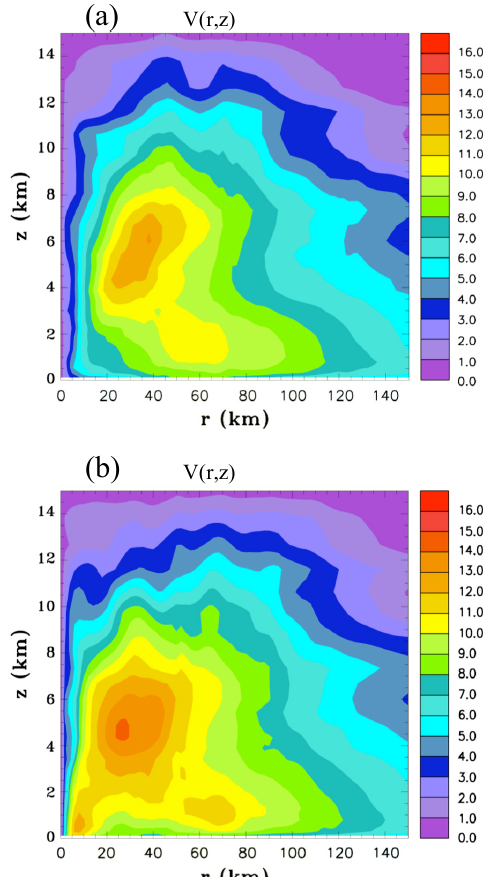
Fig. 5. Azimuthally averaged tangential velocity V (r,z) for Exper- iment 2, at (a) t = 79h, and (b) t = 83h. The contour interval is 1ms − 1 . Figure 5. Azimuthally averaged tangential velocity V(r,z) for Experiment 2, at (a) t=79 h, and (b) t=83 h. The contour interval is 1 m s -1 .